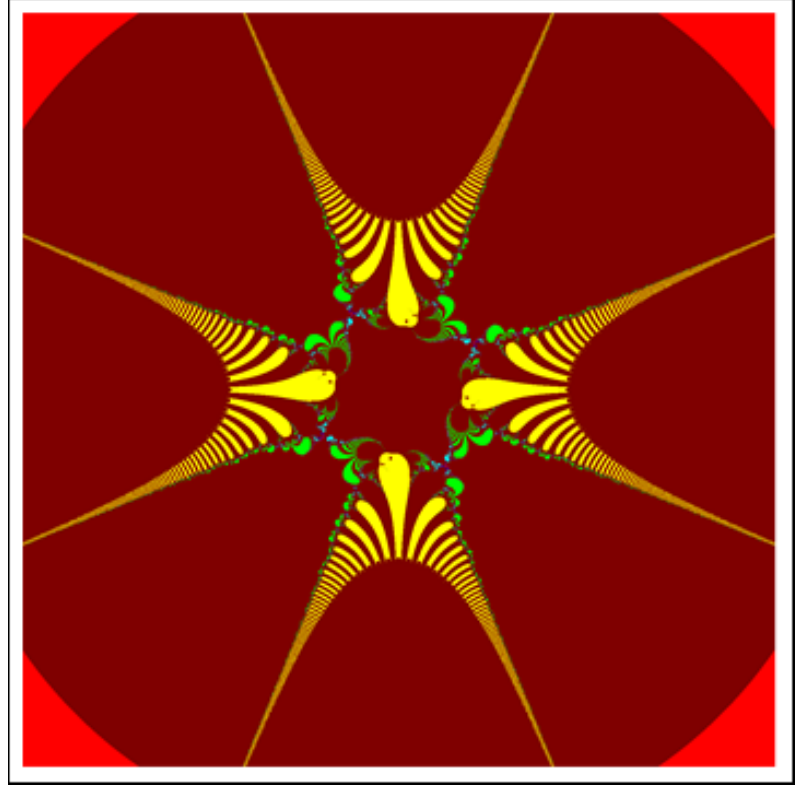
Figure 15. J-set for τ ( z ) = e z 4 + c via DKIS. The image execution time is 1367.6